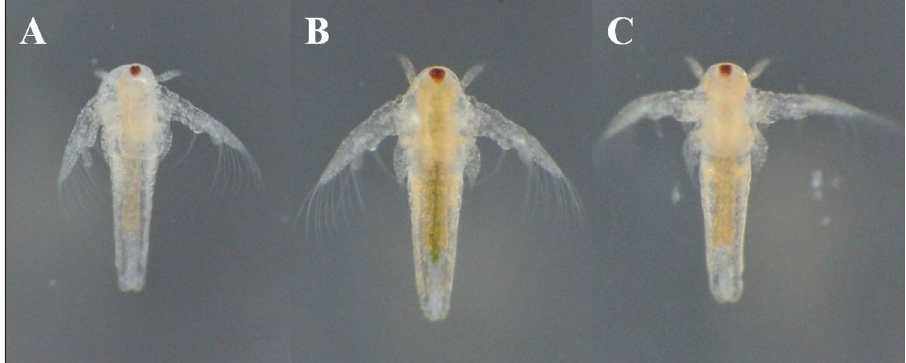
Figure 2. Enriched Artemia nauplii . Unenriched Artemia (A) are shown next to Artemia that were enriched for 3 h with spirulina (B) and SBM (C)